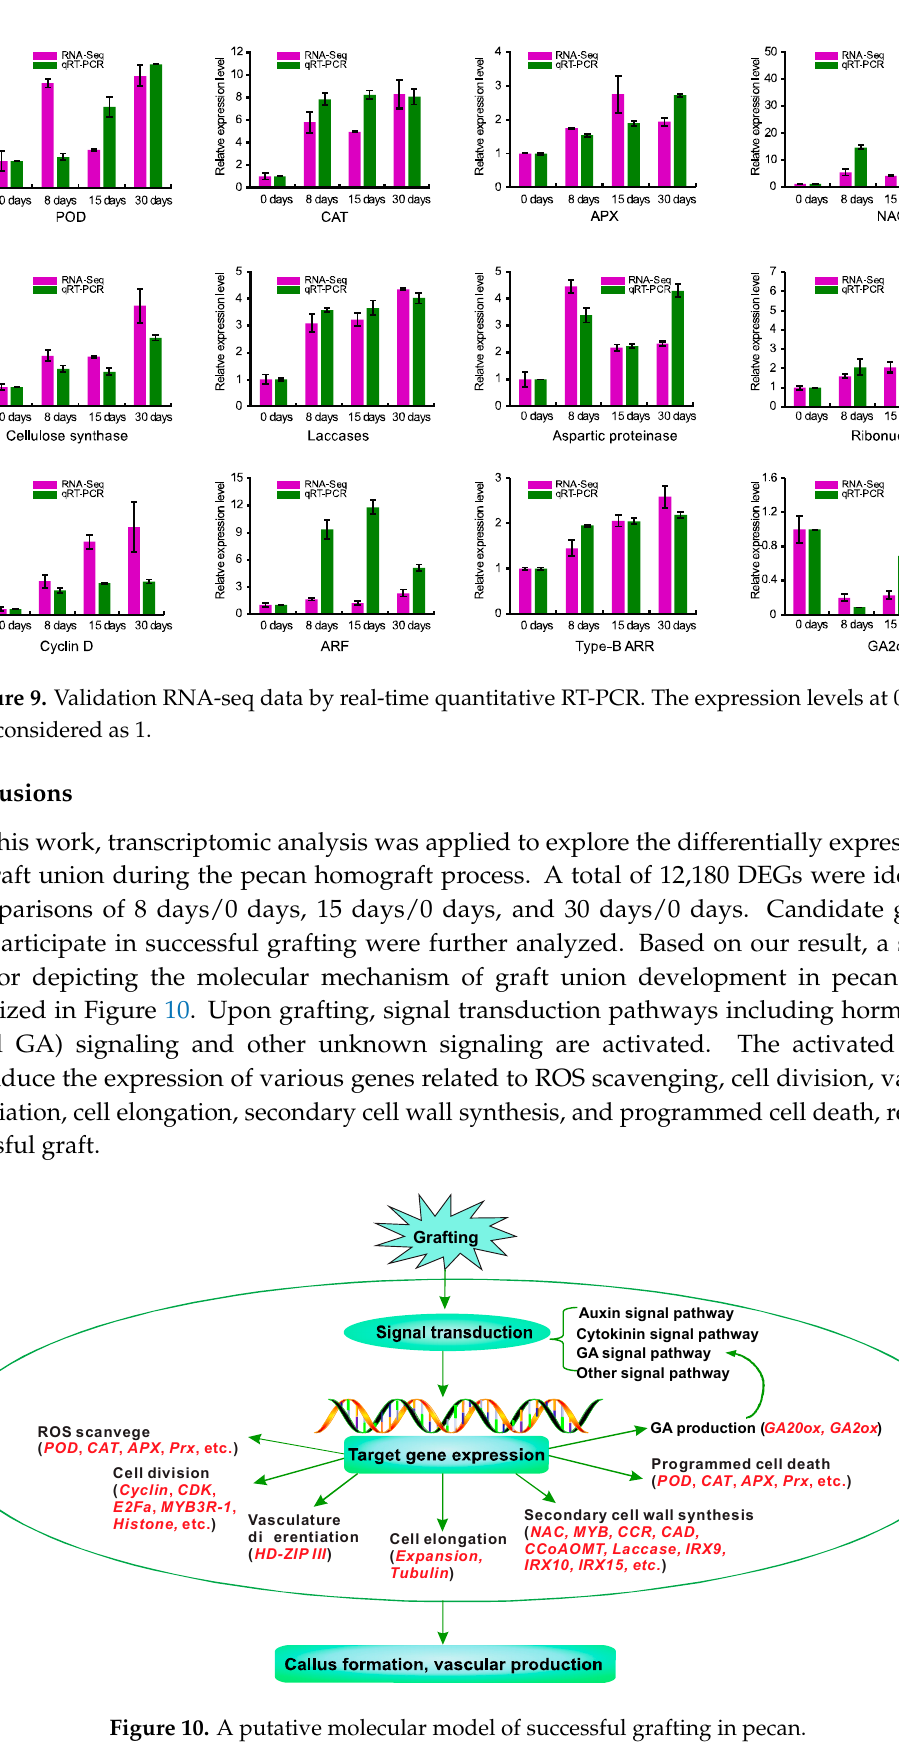
Figure 10. A putative molecular model of successful grafting in pecan.